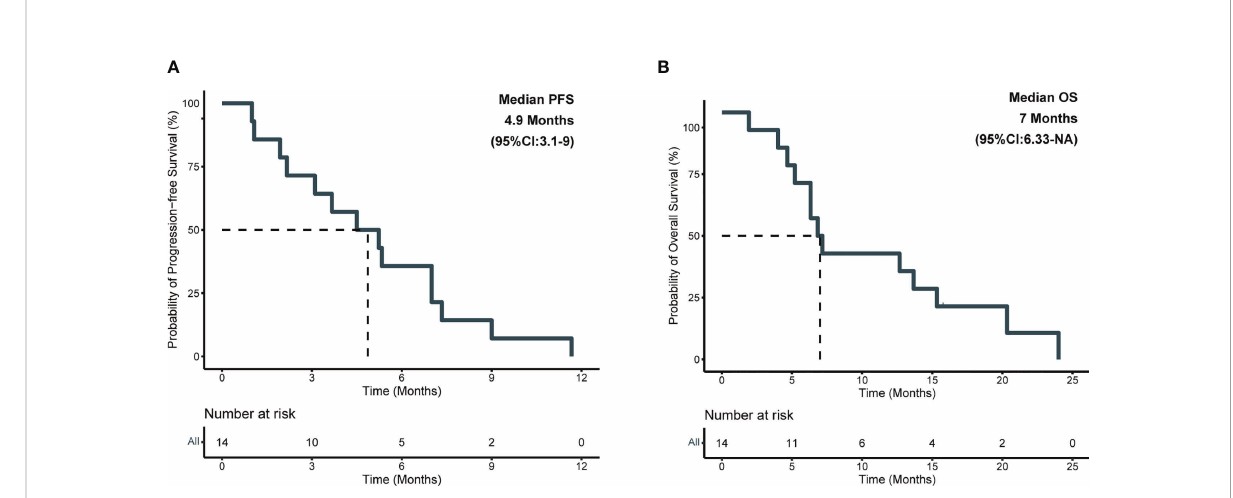
FIGURE 3 Kaplan-Meier survival analysis in anlotinib group. (A) Plots of progression-free survival (PFS); (B) Plots of overall survival